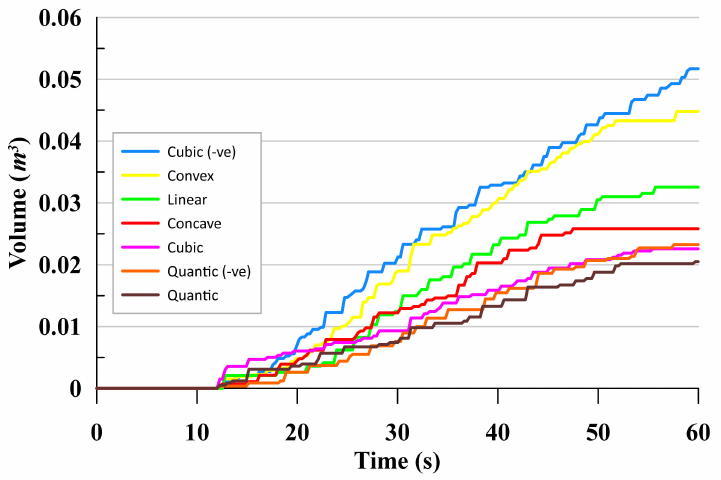
Figure 12. Comparison of overtopping volume for di ff erent ramp